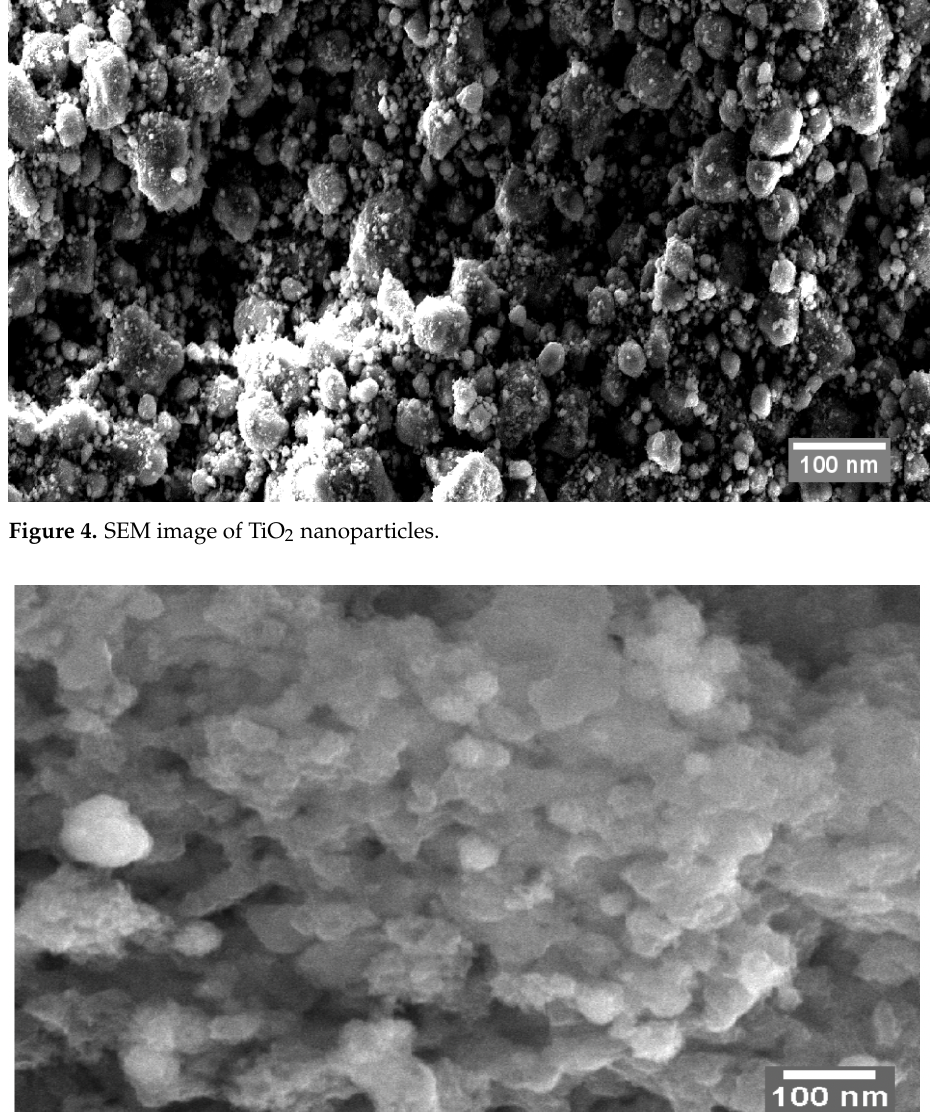
Figure 5. SEM image of mancozeb nanoformulation.